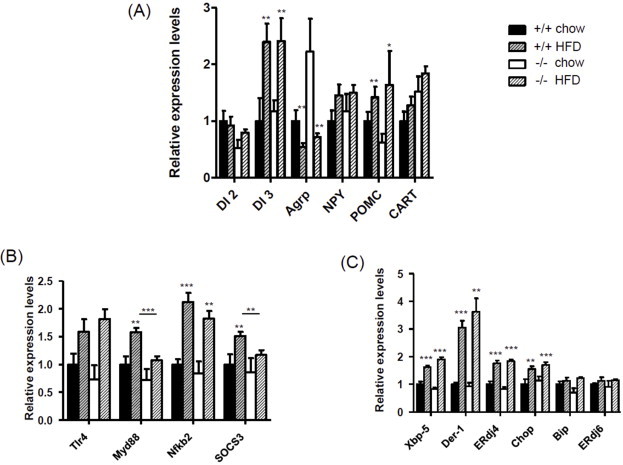
Relative mRNA levels for (A) classical hypothalamic neuropeptide; (B) NFκB pathway related genes and (C) markers of endoplasmic reticulum stress were determined by quantitative RT-PCR in the hypothalamus of Fto+/+ and Fto−/− mice fed either a normal chow or exposed to 5 weeks of high-fat diet from 8 weeks of age. Data are means ± SEM. *, p < 0.05; **, p < 0.01; ***, p < 0.001 following two-tailed t-test. Each mRNA was normalised to housekeeping Tbp mRNA in the same sample.